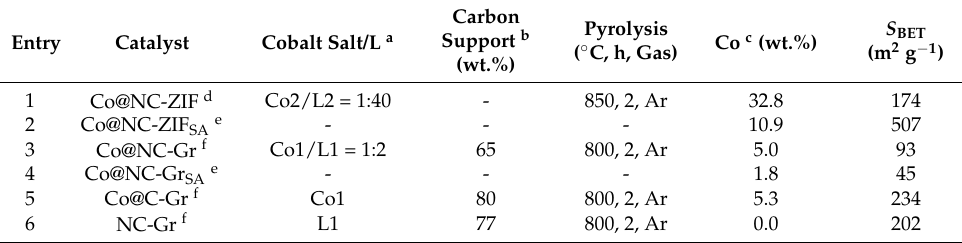
Table 2. Characterization data for Co@NC